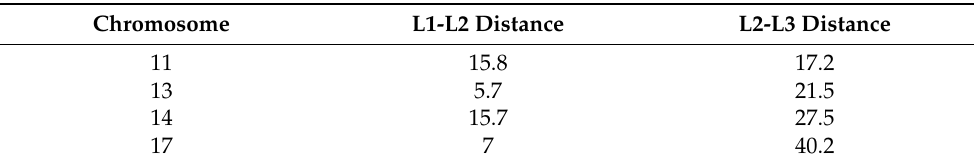
Table 1. Distances between fluorescent in situ hybridization (FISH) regions computed from CBCR models at 250 kb resolution.